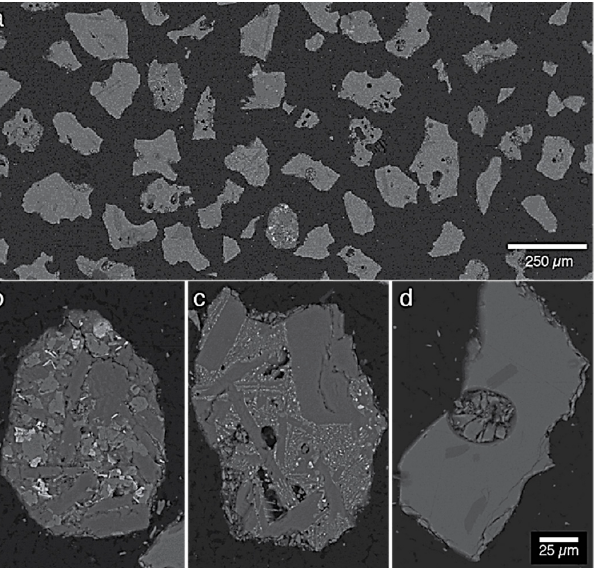
Figure 5. Surtsey ash-grains (from the Icelandic Natural History Museum samples collection, Table 1); shapes and microtextures. ( a ) Overview of BSE image of fine ash (3.0–3.5 Φ ) in a polished grain mount. ( b ) ‒ ( c ) Tachylite and ( d ) sideromelane.